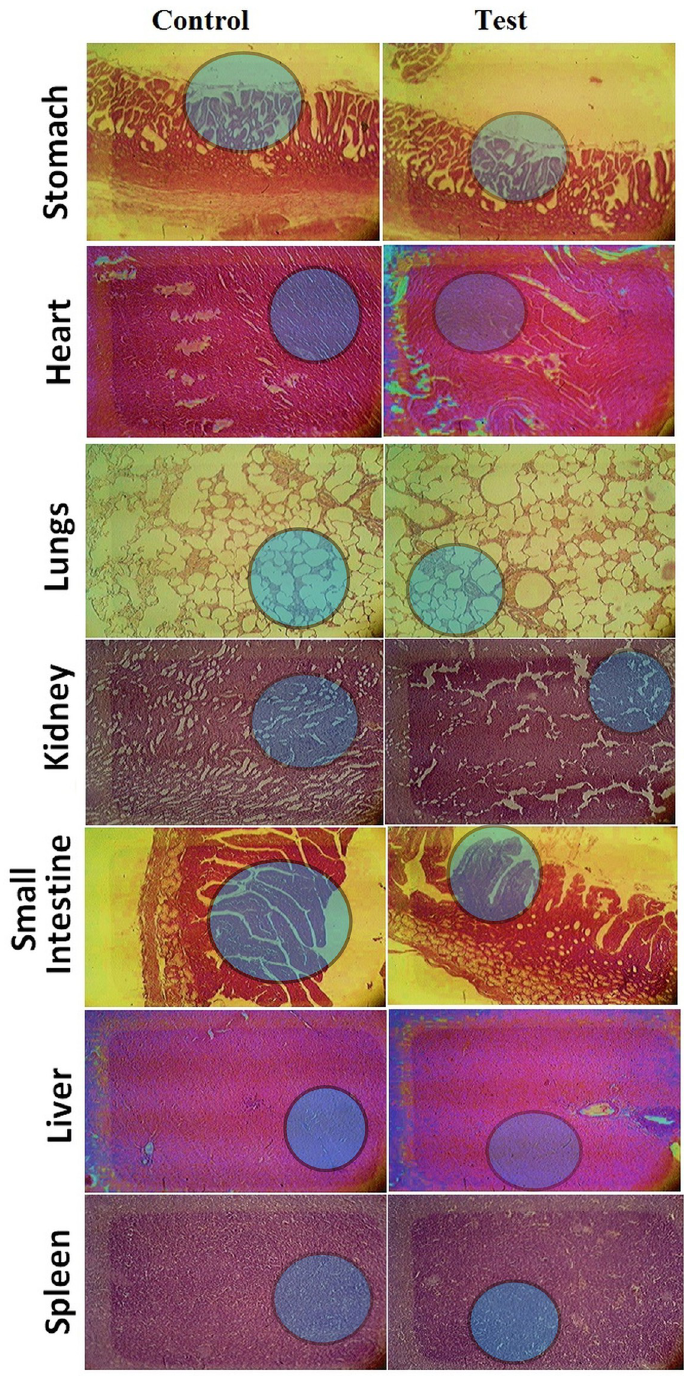
Fig 9. Histopathological tissues examination of different organs from both control and nanogel-treated group indicating no major difference.